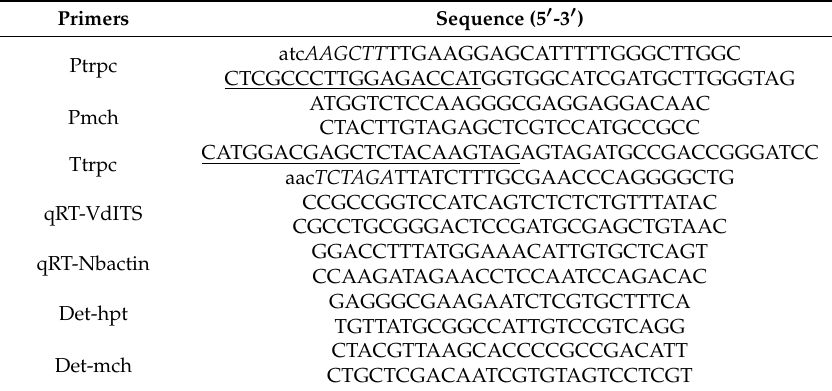
Table 1. Primers used in this